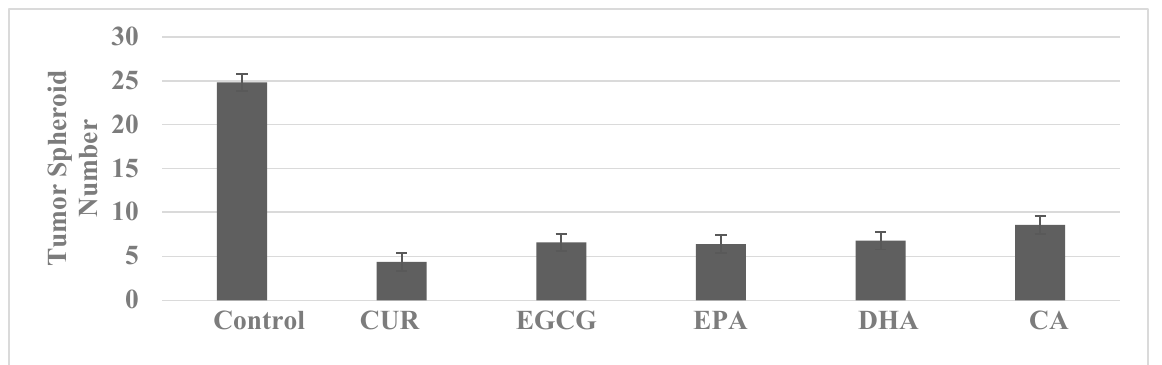
Figure 6. Inhibition of tumor spheroid formation by phytochemicals. CUR, curcumin; EGCG, epigallocatechin gallate; EPA, eicosapentaenoic acid; DHA, docosahexaenoic acid; CA, carnosic acid.